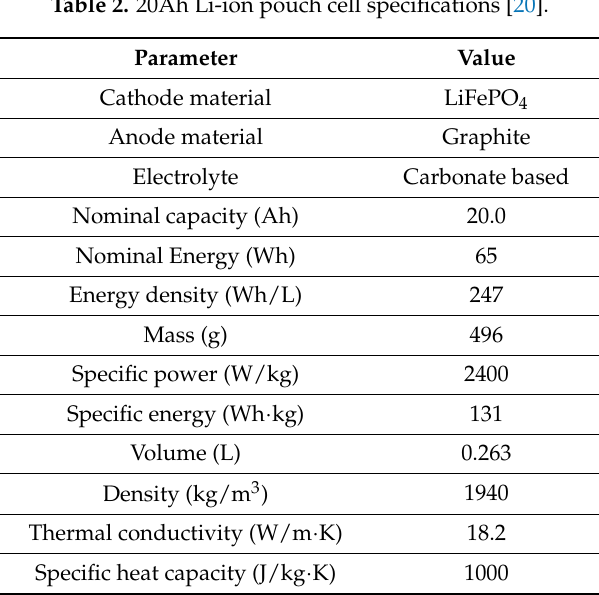
Table 2. 20Ah Li-ion pouch cell specifications